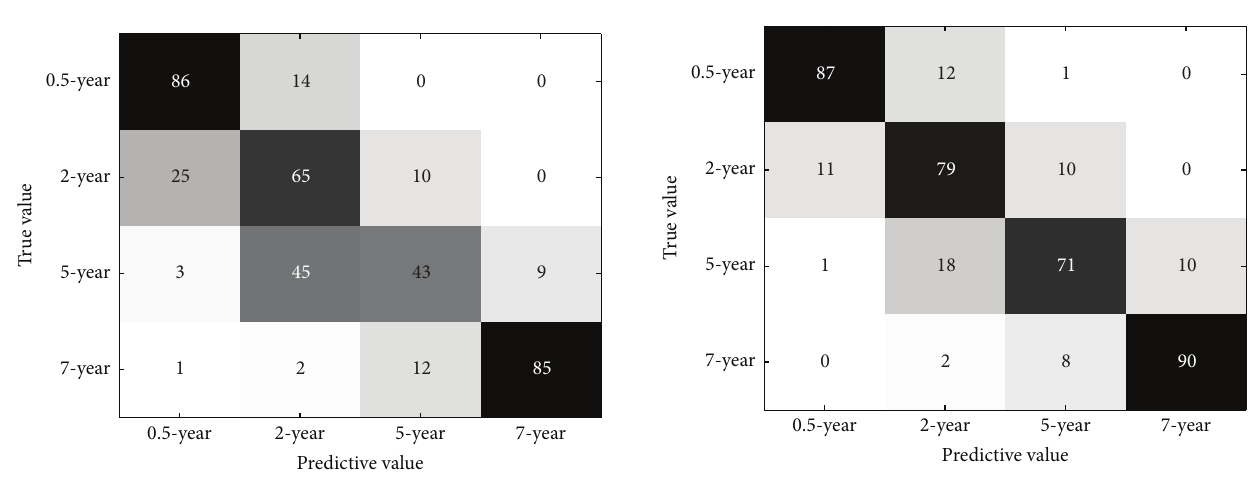
Figure 8: Unoptimized DFNN confusion matrix for testing sam- ples.